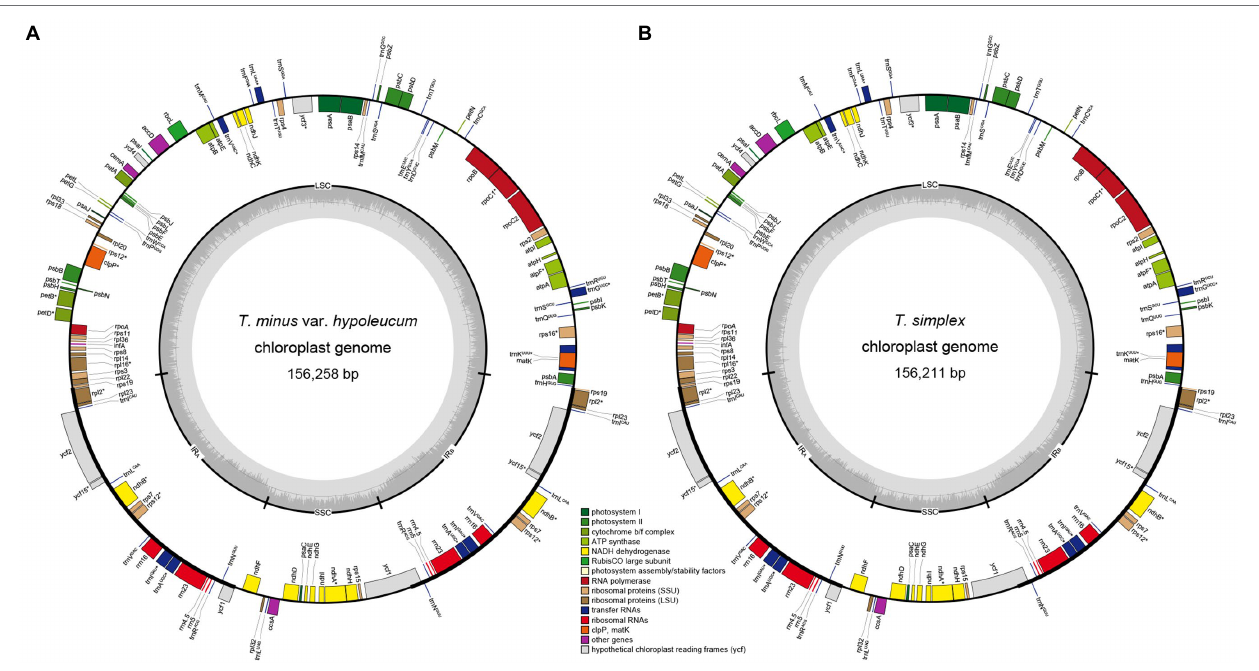
FIGURE 1 | Plastome of Thalictrum minus var. hypoleucum (A) and Thalictrum simplex (B) . The genes inside and outside of the circle are transcribed in clockwise and counterclockwise directions, respectively. Genes belonging to different functional groups are shown in different colors. The thick lines indicate the extent of the inverted repeats (IR A and IR B ) that separate the genomes into small single-copy (SSC) and large single-copy (LSC)